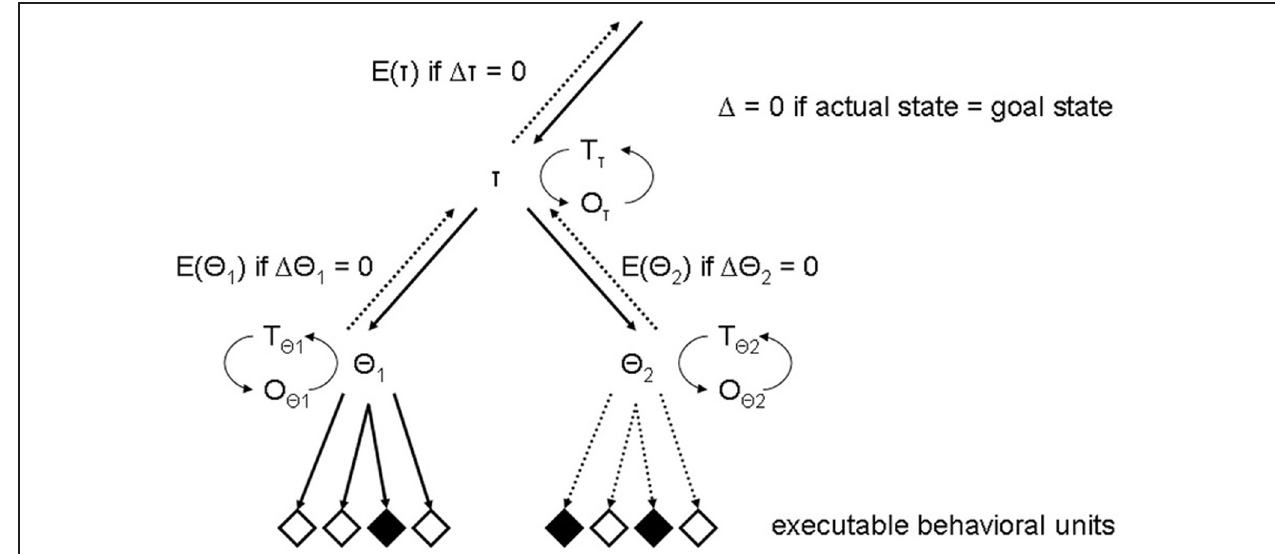
FIGURE 2 | Illustration of a recursive mental TOTE model capable of controlling intentional behavior (just two levels are drawn for illustration). TOTE units are self-terminating operating units, each capable of activating otherwise comparable units at sub-ordinate levels of the hierarchical structure (top-down arrows). The exit-operator of the active TOTE unit passes control of operations to the super-ordinate TOTE unit (bottom-up arrows), once the self-terminating condition is reached. Each TOTE unit is comprises three operators (T, test; O, operation; E, exit). Activated test-operation-retest loops are running until the actual state matches the goal state. The exit-operator is executed (i.e., E()) whenever the self-terminating condition is reached (i.e., (cid:2) = 0), so that control of operations is passed to the super-ordinate unit. Only TOTE units at the lowest level of the hierarchical structure are capable of activating executable behavioral units, whereas units